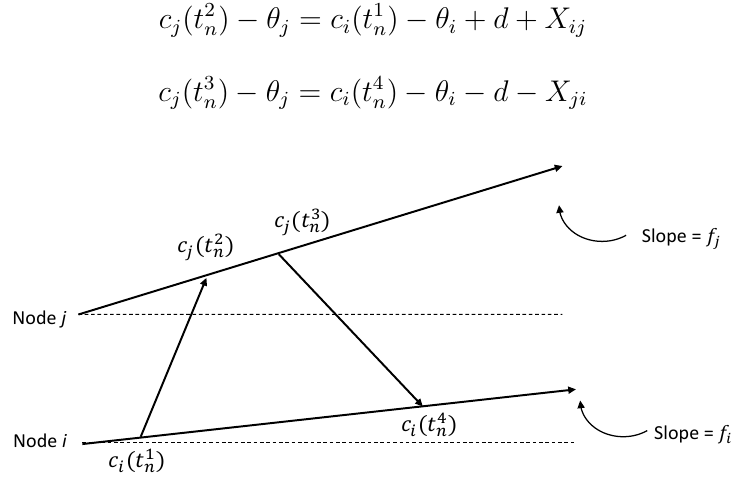
Figure 4. Two-way message exchange between nodes i and j